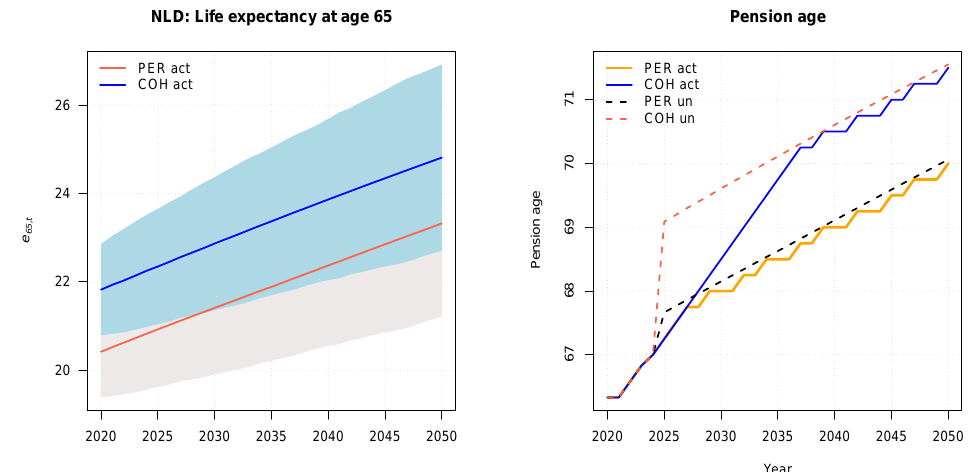
Figure 2. NLD: BME forecast of unisex period and cohort life expectancy and pension age along with 95% prediction intervals.